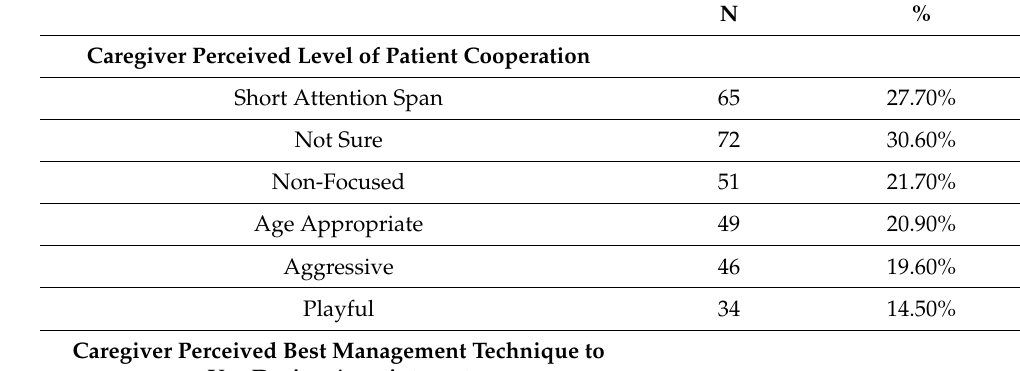
Table 4. Patient behavioral